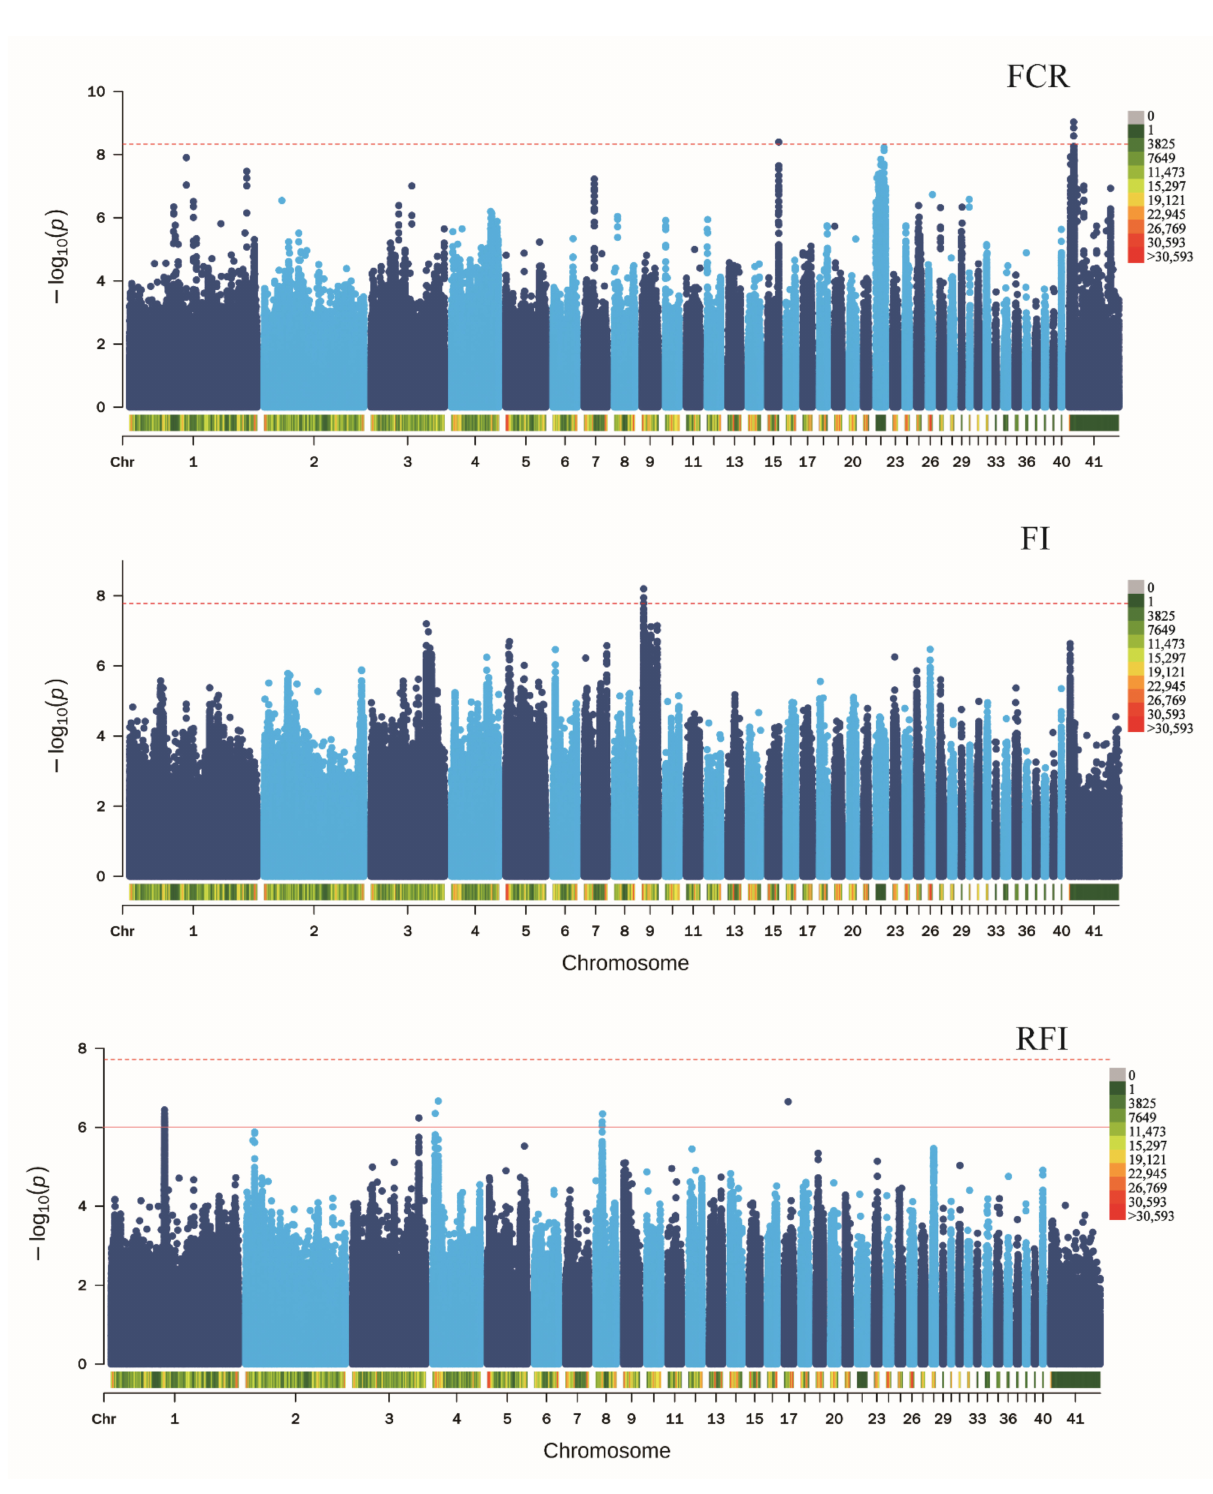
Figure 3. Genome-wide association study of the three FE traits in ducks. Manhattan plots in which the genomic coordinates of the SNPs are displayed along the horizontal axis, the negative logarithm of the association p -value for each SNP is displayed on the vertical axis. The red line indicates the significance threshold level after Bonferroni